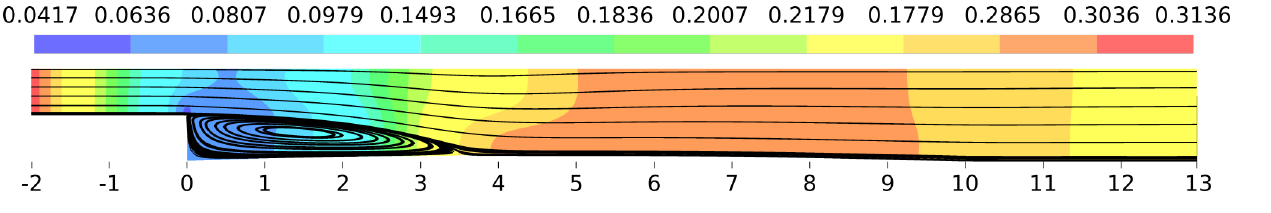
Figure 8. Pressure contours and streamlines for BFS with control portion l = 10 of elastic membrane bottom wall, with T m = 55 and p e = 0.525, at steady flow with Re = 400 for − 2 ≤ x ≤ 13.